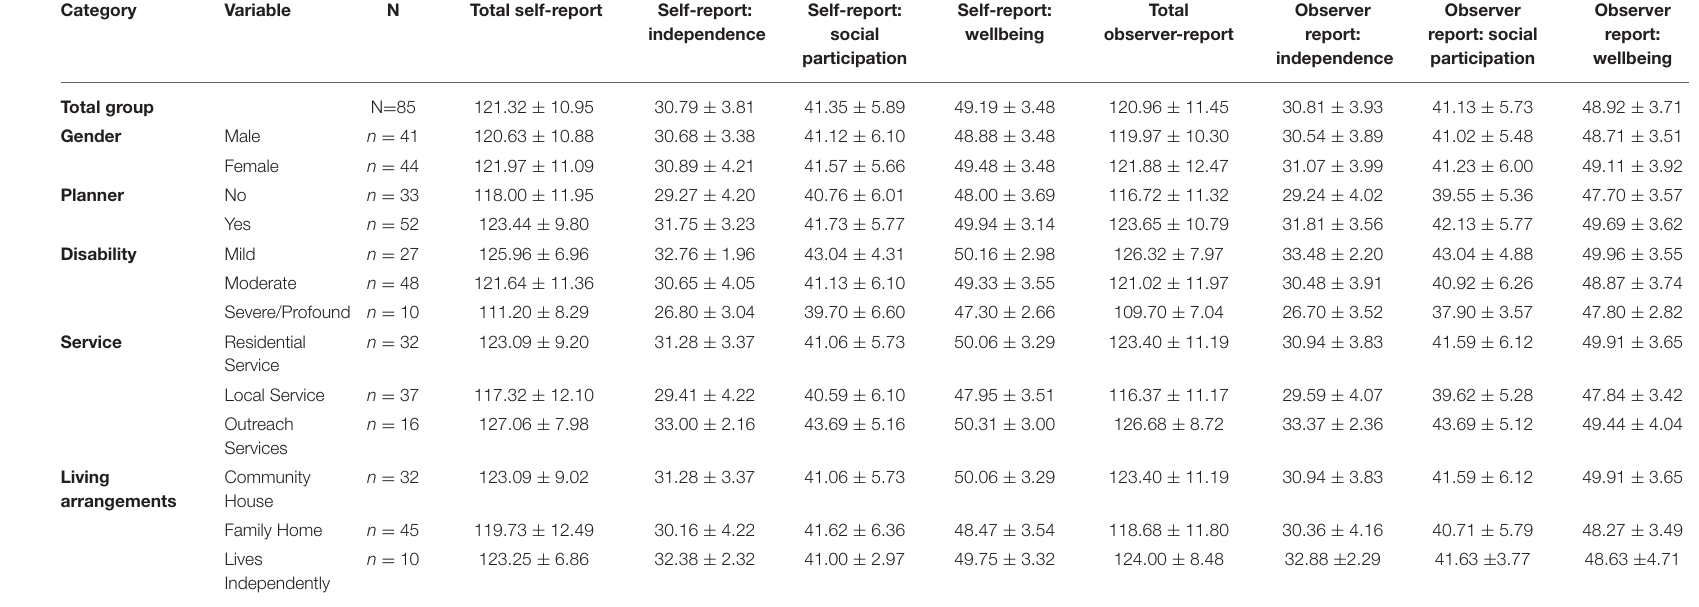
TABLE 1 | Outcome on the POS for the total group (N = 85), with outcomes reported based on demographic and service-specific